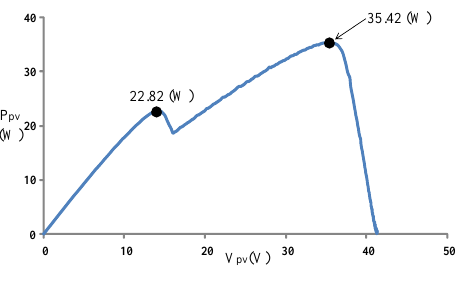
Figure 9. P–V characteristic curve of Case